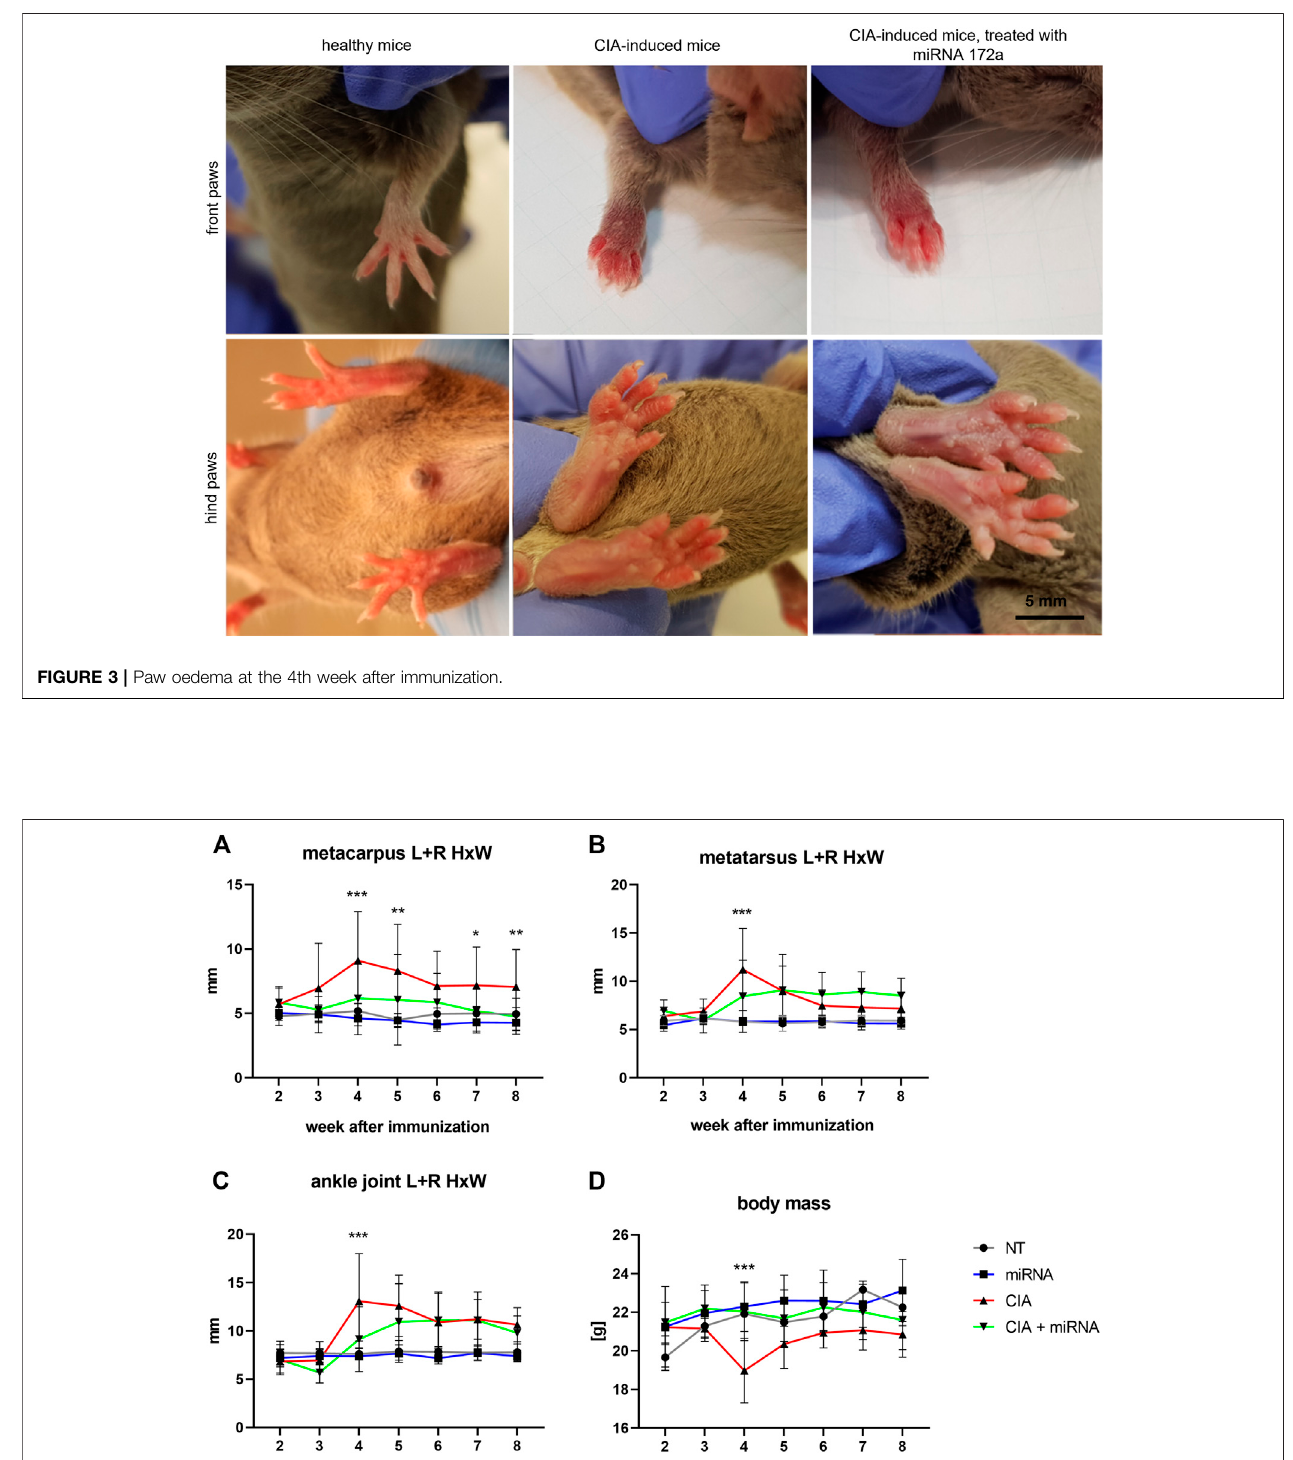
Frontiers in Pharmacology |